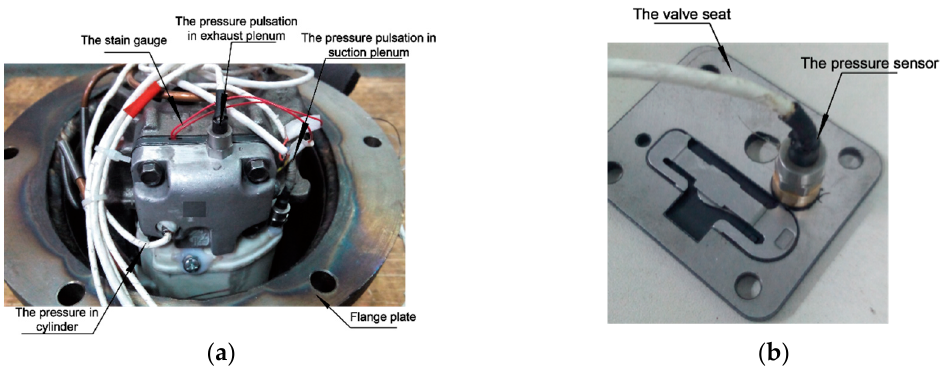
Figure 2. Schematic of sensor installation: ( a ) The special experimental installation for strain; ( b ) The reed valve.